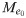
Correlation analysis for model (3) before and after being locally structural identifiable.Correlation matrices for model (3) using the Pearson correlation index. Strong correlation (|index| > 0.8) suggest that the parameters are unidentifiable. Here we present the correlation matrices for two noise levels, σ = 1% (ARE1) and σ = 40% (ARE40). Before we fixed Me0 we found a strong positive correlation between Me0 and Hs0 for low noise level; on the other hand, after fixing Me0 we found strong negative correlation between transmission rates (βh and βm), as well as between Hs0 and θh for high noise level. Those negative correlated parameters correspond to the unidentifiable ones from Fig 6.